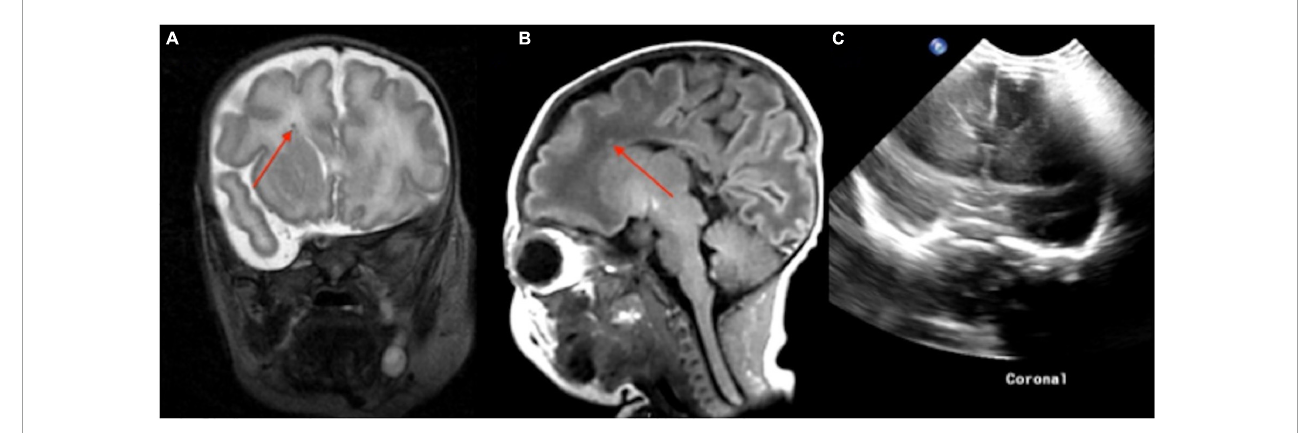
FIGURE5 In a routine pre-discharge point-of-care 1-Tesla MRI of a preterm infant, there was a punctate focus of T1 hyperintense (A) and T2 hypointense (B) microbleed in the left anterior periventricular white matter which was not visualized on preceding transcranial ultrasound performed 5 weeks earlier (C) .